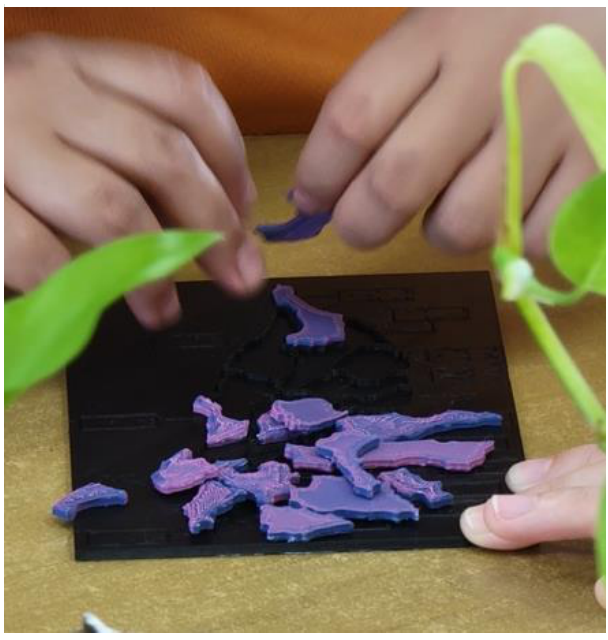
Figure 9. Students from the VIB school testing the tactile educational materials.